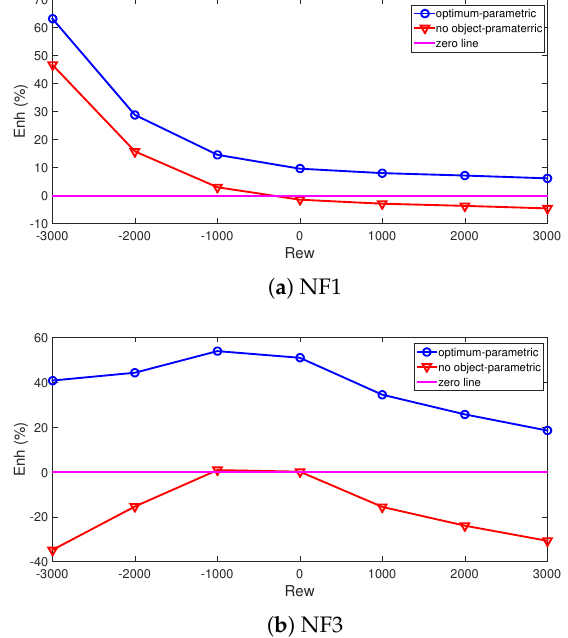
Figure 13. Enhancement in the generated power versus Rew when the optimum-parametric CFD and no object-parametric CFD cases are compared for NF1 ( a ) and for NF2 ( b ).